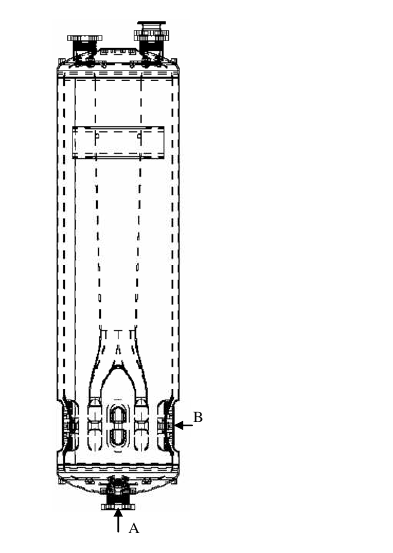
FIG. 9. Cross section of the type-II cavity in the SS jacket.